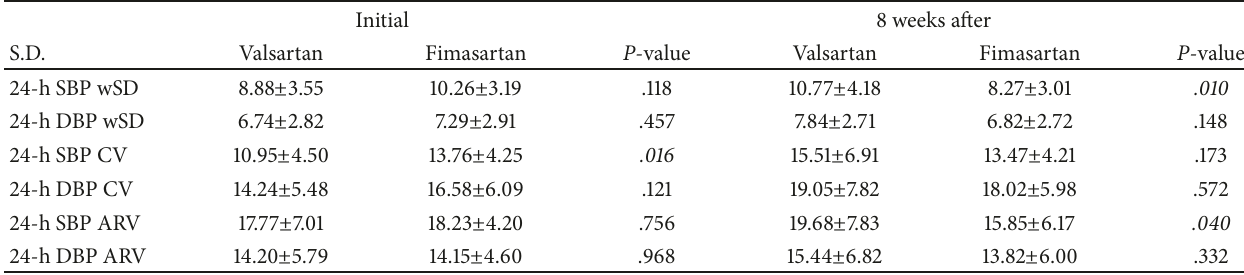
Table 2: BPV-the other